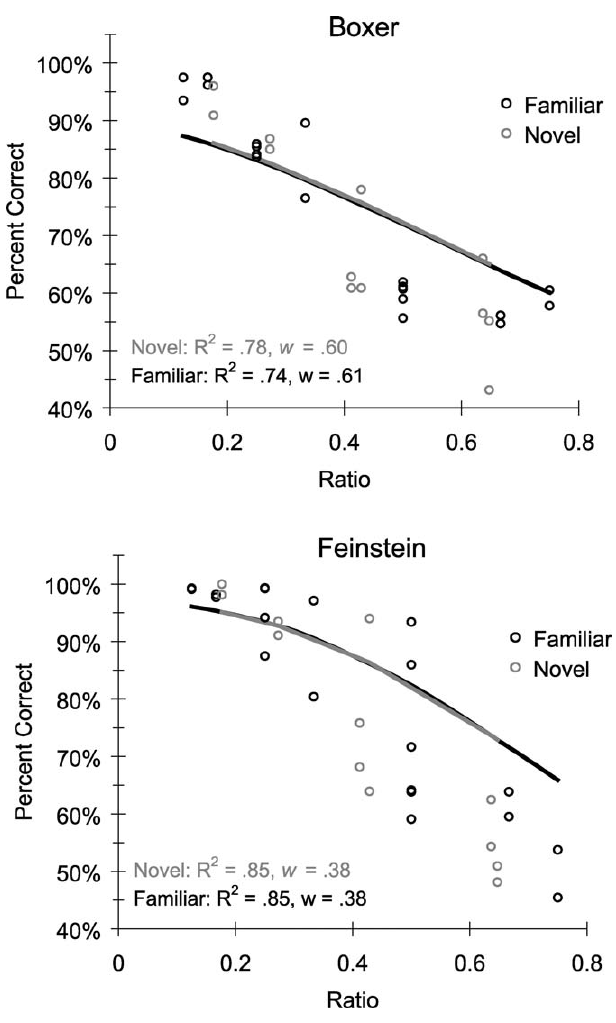
Figure 4. Monkeys Can Solve Novel Addition Problems Both monkeys performed significantly above chance on the novel and familiar addition problems, and their performance was similarly modulated by the ratio between the numerical values of the sum and distractor choices. Solid lines represent the predicted data from Equation 1 at the best-fitting w . R 2 values reflect the fit between the predicted and actual data for familiar trials (black) and novel trials (gray; all p ’s ,